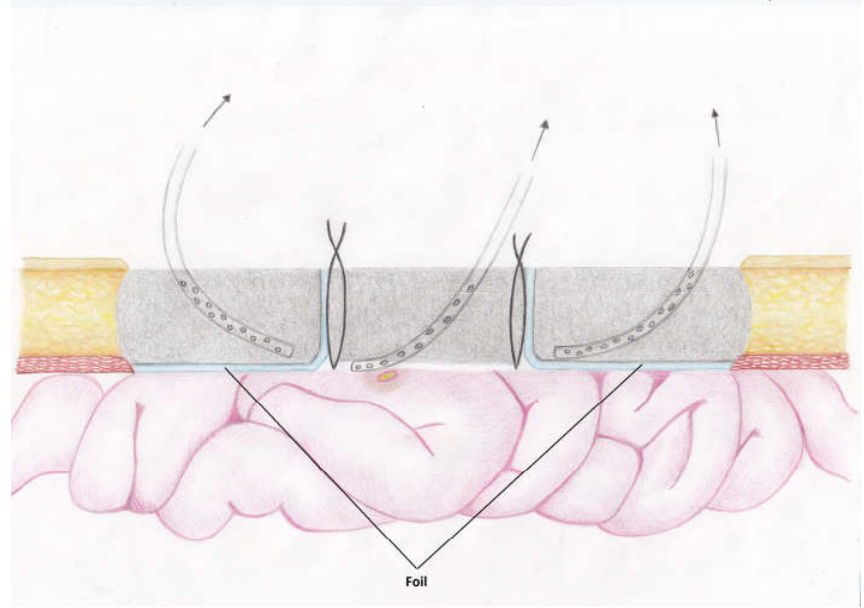
Figure 4. Schematic view of the proposed modification.